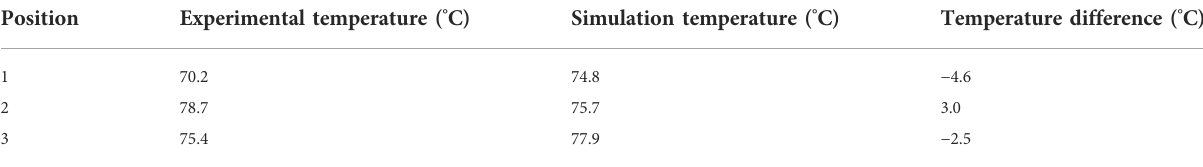
TABLE 7 Temperature comparison between experiment and simulation with slotted layer at different positions. Position